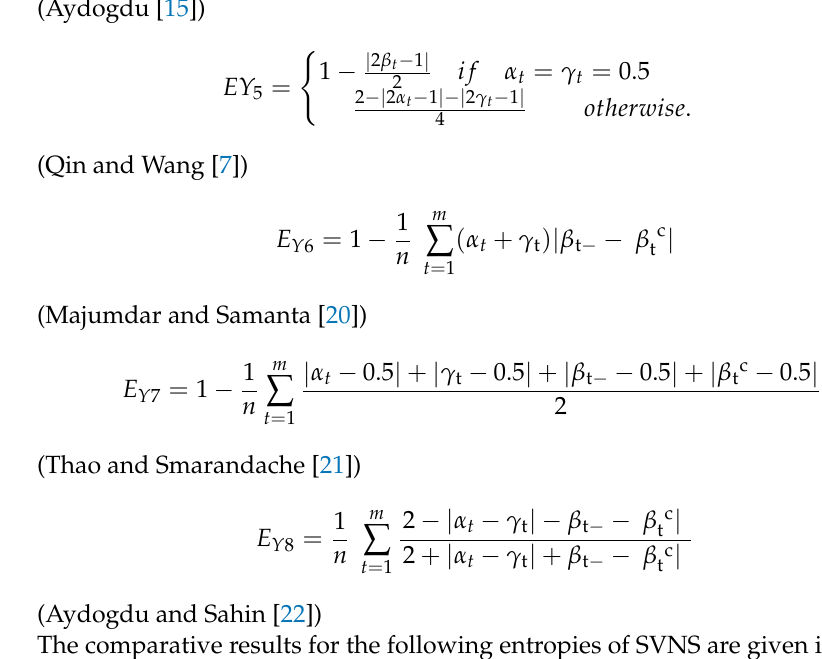
The comparative results for the following entropies of SVNS are given in Table 11. Table 11. Computed entropies/knowledge measures of